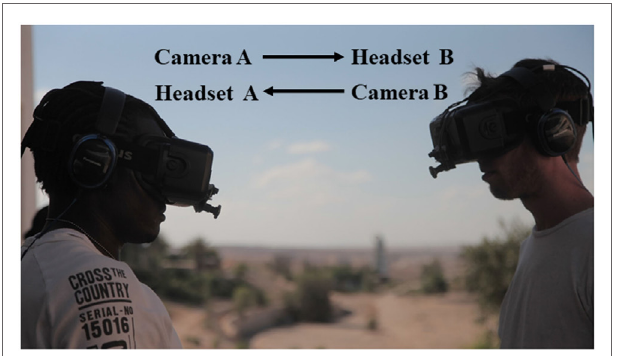
FiGURe 1 | Functional diagram of two users swapping bodies through the system The Machine to Be Another. In this interactive mode, both users have to mirror each other in order to move in syncrony. Picture from workshop held by BeAnotherLab in 2015 at detention center for asylum seekers in